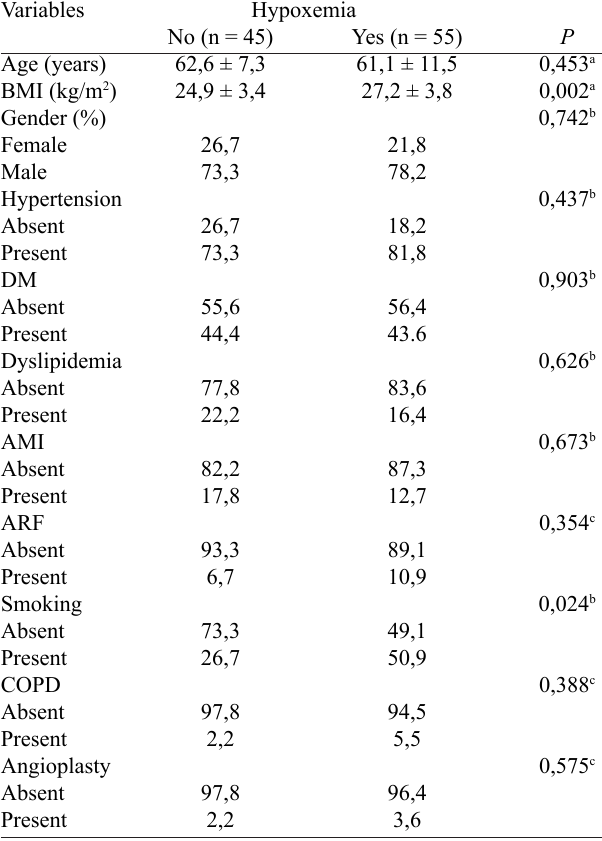
Table 1. Univariate analysis of preoperative variables. (n =